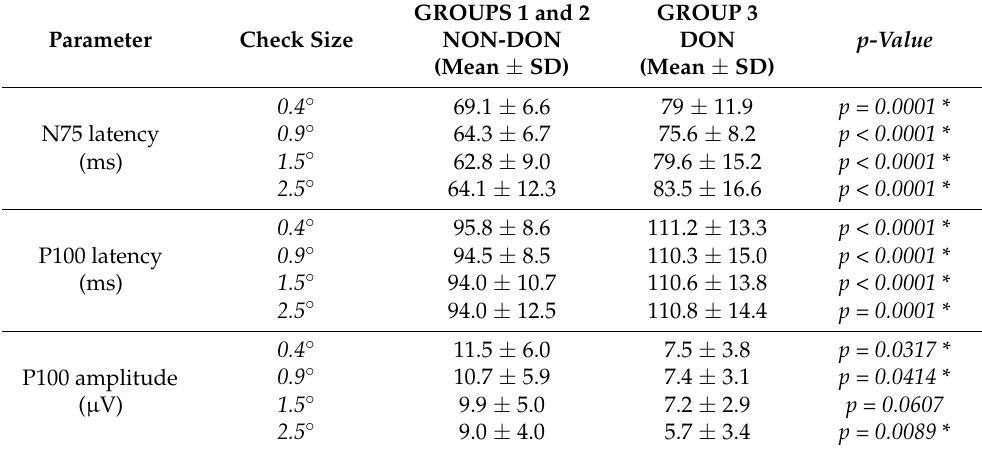
Table 2. A comparison of visual evoked potential (VEP) components between GO patients with no clinical evidence of dysthyroid optic neuropathy (DON) (Groups 1 and 2) and patients with confirmed DON (Group